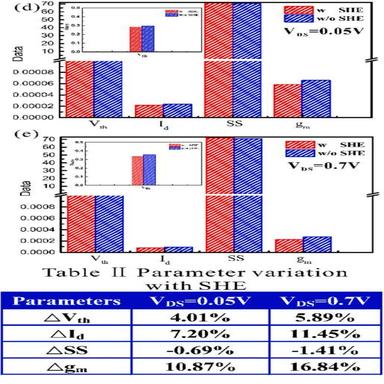
(a) Comparsion of IDS - VGS characteristics between the simulated device and the Intel's 14 nm node technology, both the linear and saturation are included; (b) Comparison of IDS - VDS characteristics between the simulated device and the Intel's 14-nm node technology under different VGS; (c) The IDS - VGS comparison of FinFET for with and without SHE; (d) and (e) Vth, Id, gm and SS comparison of the device for with and without SHE in VDS = 0.05 V and VDS = 0.7 V.